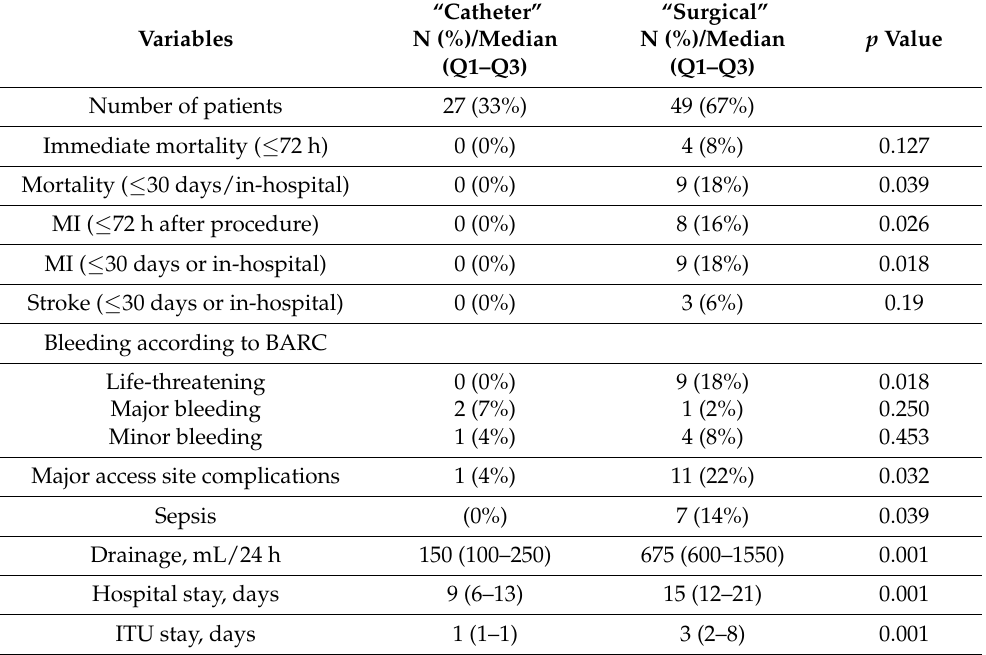
Table 2. Early postoperative data and complications.